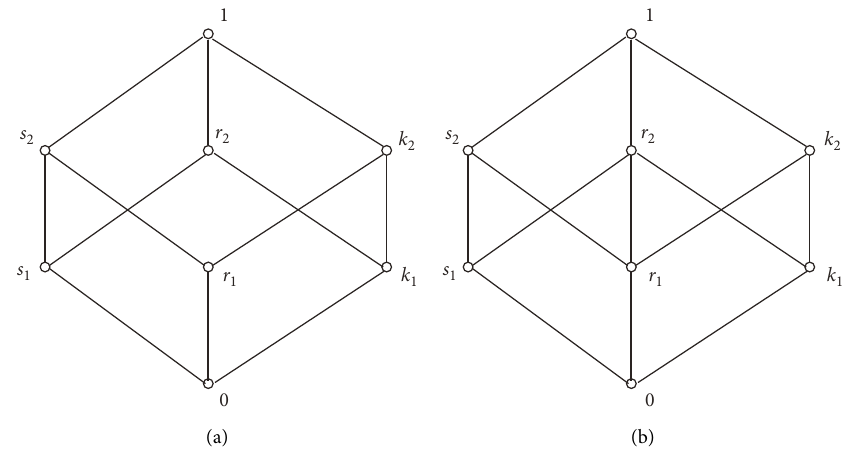
Figure 5: Lattice C